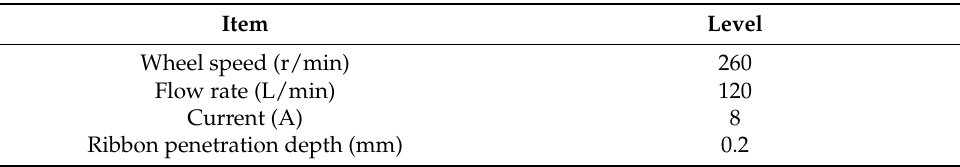
Table 1. Parameters of the MR